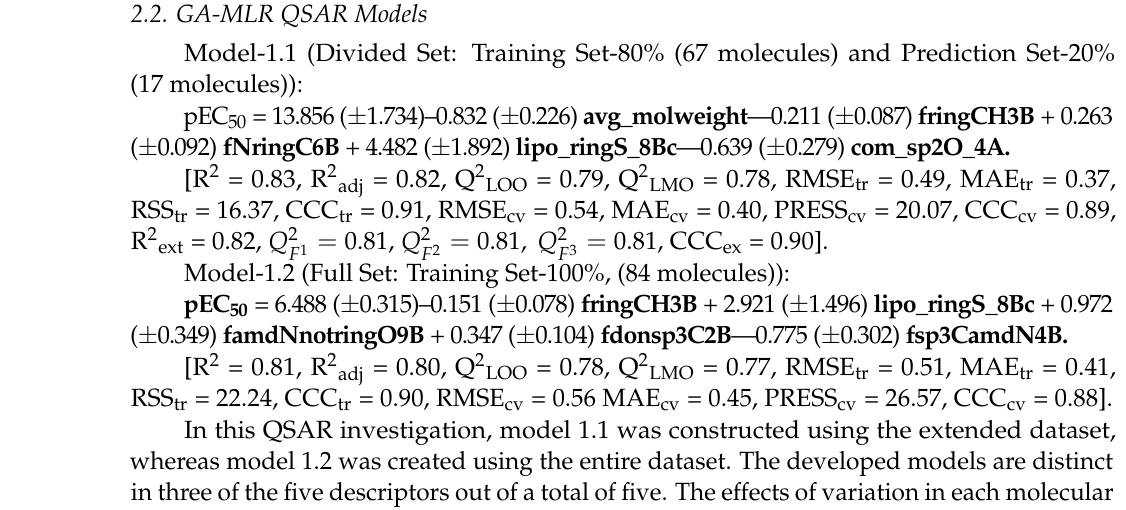
Figure 2. ( A ) Graph of experimental vs. Predicted pEC 50 values for model 1.1. ( B ) Williams plot for model 1.1. ( C ) Graph of experimental vs. Predicted pEC 50 values for model 1.2. ( D ) Williams plot for model 1.2.